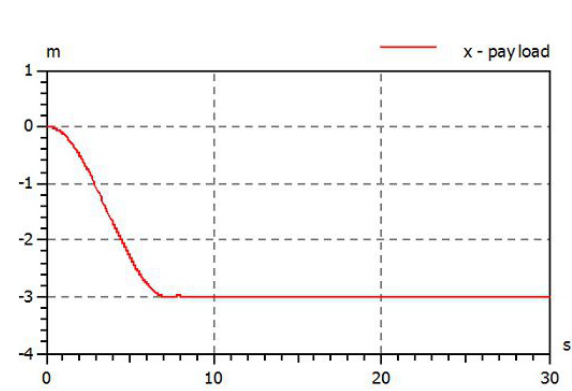
Figure 16. Set point was set to 0 m and movement shows an oscil- lation of ± 1 cm.